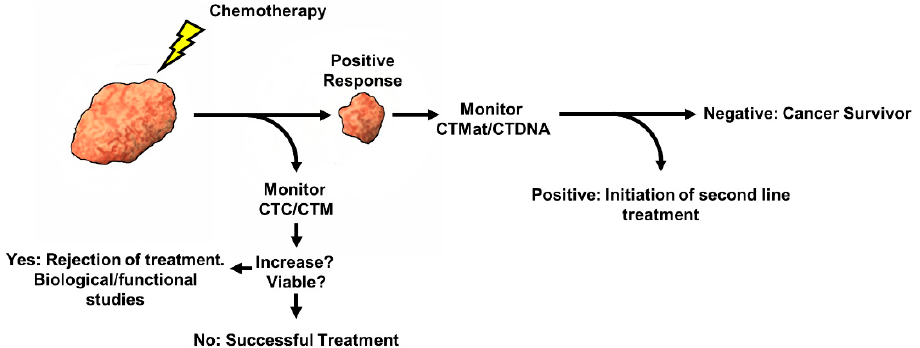
Figure 1. Workflow concept for the analysis of therapy and the early detection of relapse. After chemotherapy, patient CTCs can be analyzed for viability. An increase in viable CTCs can indicate increased mobilization and possible increased risk of relapse. After successful treatment, monitoring patient blood for telomerase activity or ctDNA can give a clinician a much earlier indication of relapse.